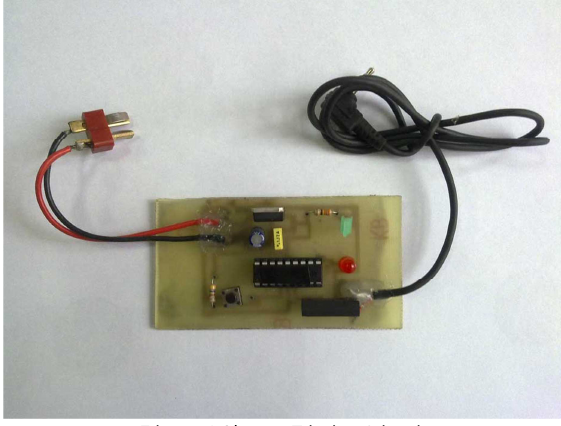
Figure 4 Shutter Timing